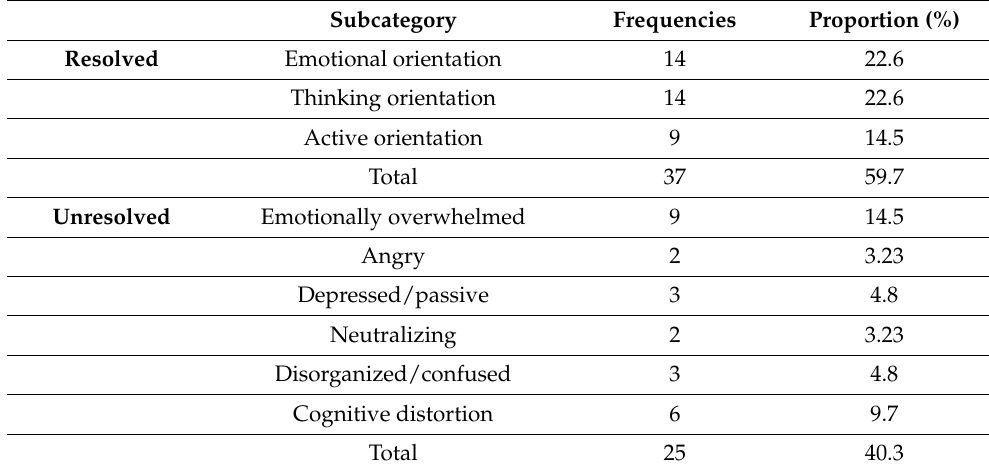
Table 1. Frequencies and proportions of the RDI